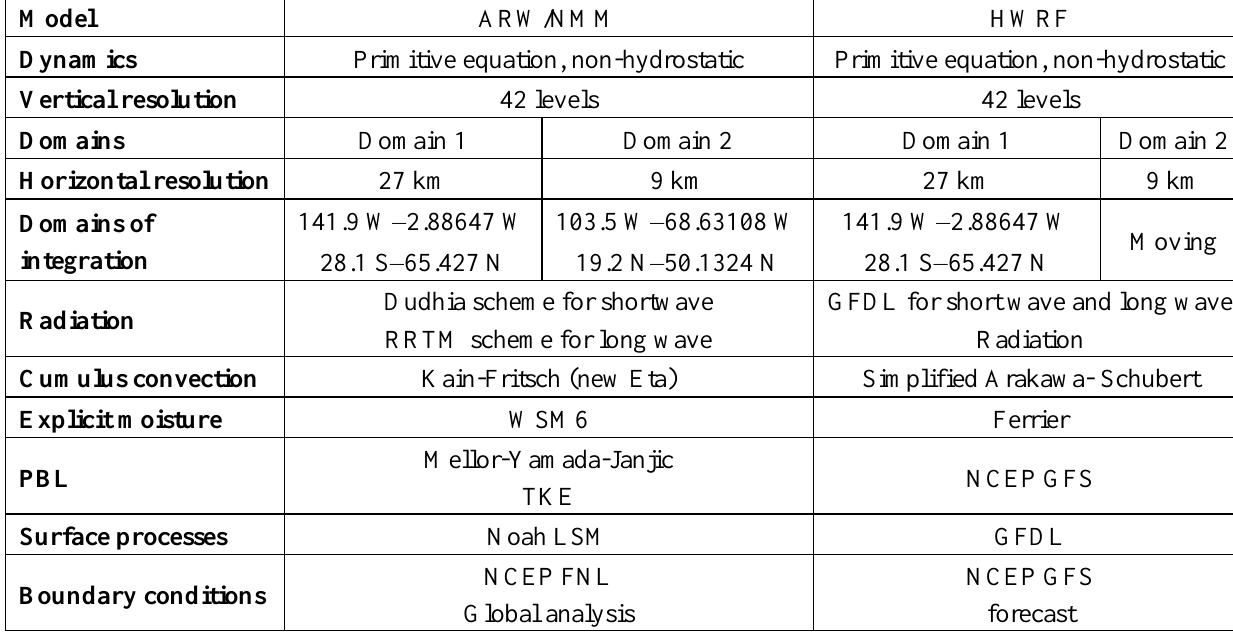
Table 1. Design of the model